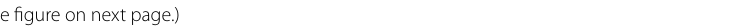
helix)(See figure on next Fig. 8 Predicted 3D model (I-TASSER) of a AmCoc encoded protein where α-helices are shown in cyan color and coils are in magenta. b Ramachandran plot (between φ-ψ torsion angles) of the predicted protein is shown where the cream areas correspond to sterically disallowed regions except glycine, red and brown areas correspond to sterically allowed regions for alpha-helical and beta-sheet conformations, and yellow areas correspond to allowed regions for the left-handed alpha-helix (A right-handed alpha-helix, B beta-sheet, and L left-handed alpha